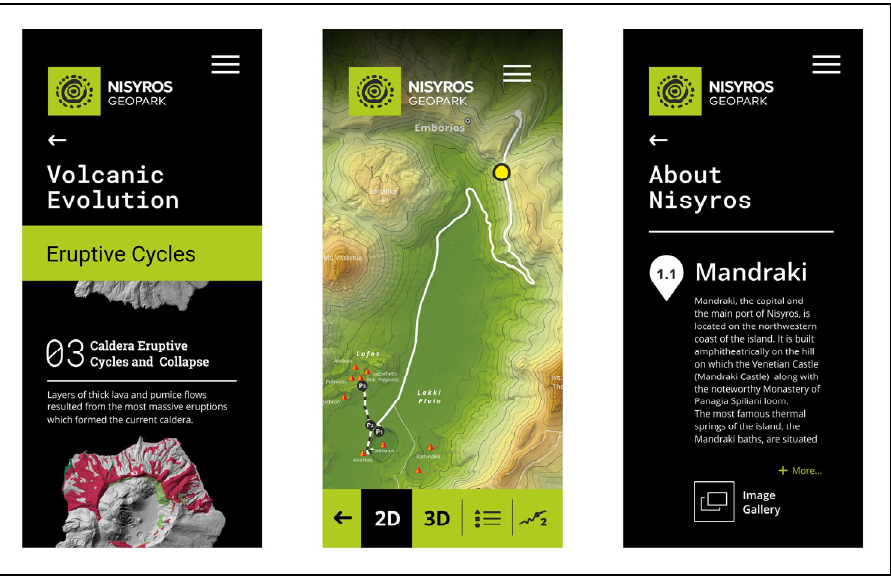
Figure 12. Screenshot examples of the contents of Nisyros Volcano App. Here, the ‘Volcanic Evolu ‐ tion’, ‘Area Map’ and ‘About Nisyros’ subunits are presented. tion’, ‘Area Map’ and ‘About Nisyros’ subunits are